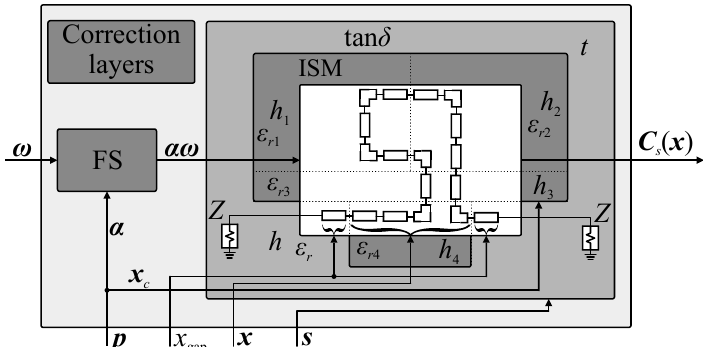
Figure 5. Surrogate model of individual CC—conceptual illustration. The correction layer parameters p = [ x c α ] T are adjusted in the course of parameter extraction process. Cell geometry and substrate parameters at the input port are maintained using x , x gap , and s parameters.